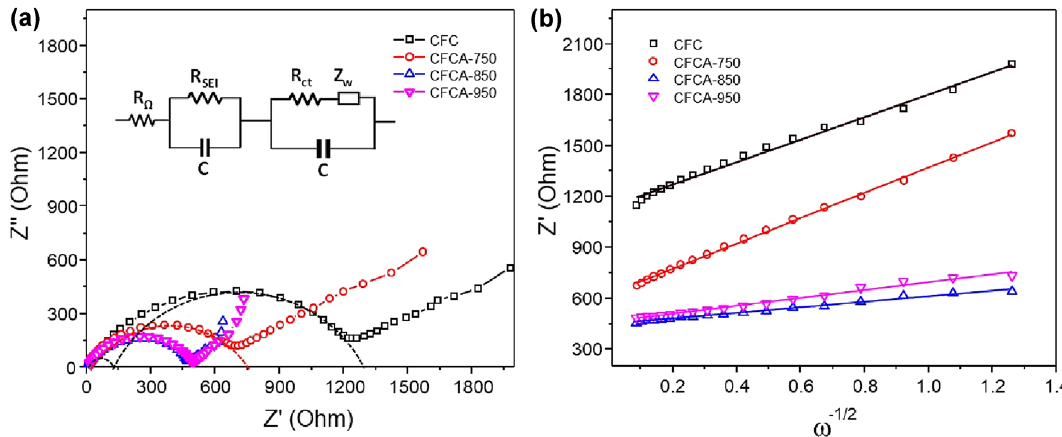
Fig. 5 a Electrochemical impedance spectra, and b the linear relationship between the Warburg impedance and the inverse square root of angular frequency of CFC and